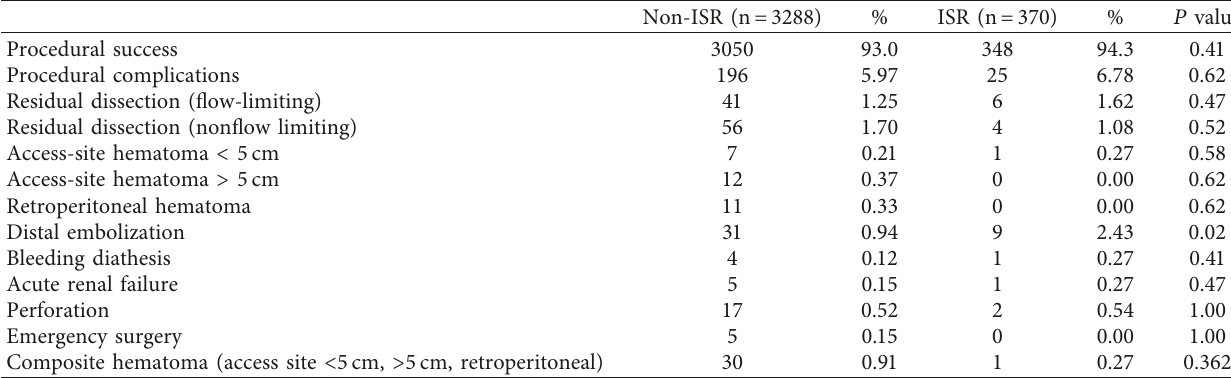
Table 4: Procedural outcomes for femoropopliteal (FP) non-in-stent restenosis and in-stent restenosis (ISR) groups.